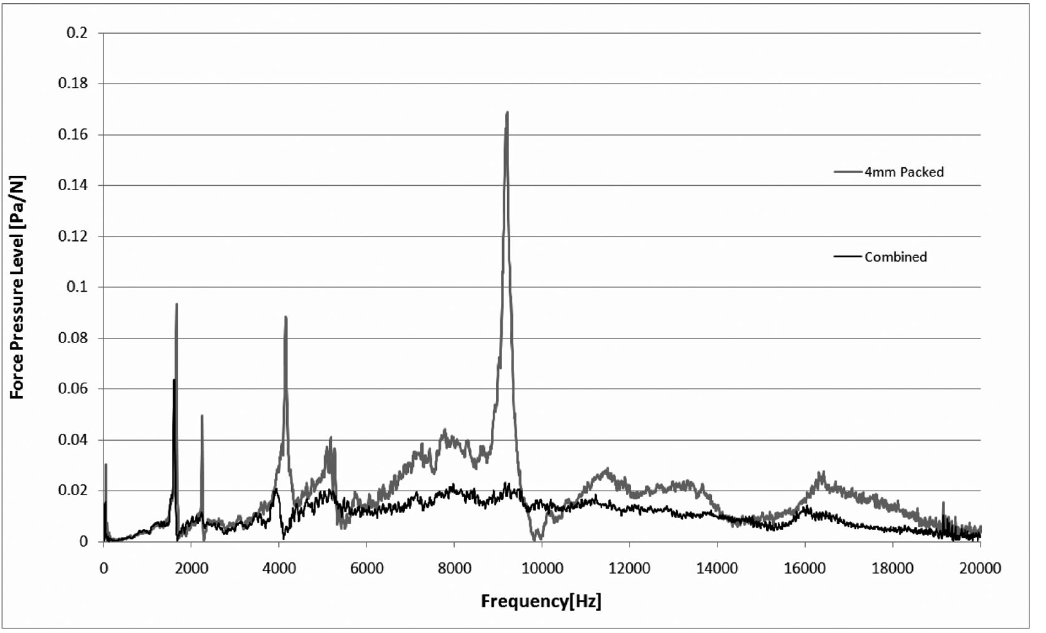
Fig. 72. 4 mm Packed Vs. Combined EIDL configuration.